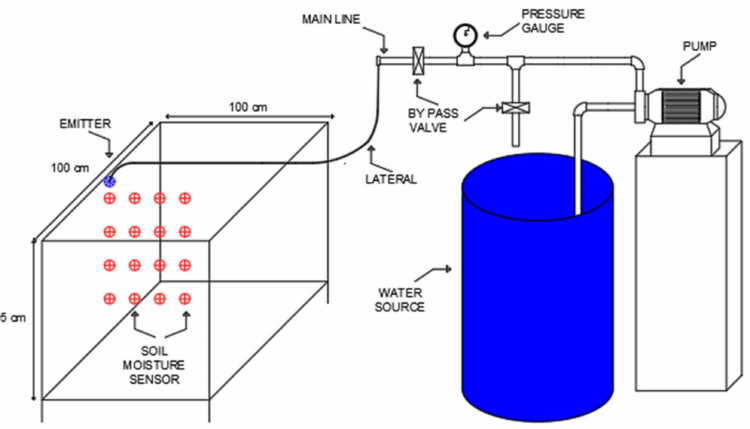
Figure 1. Experimental